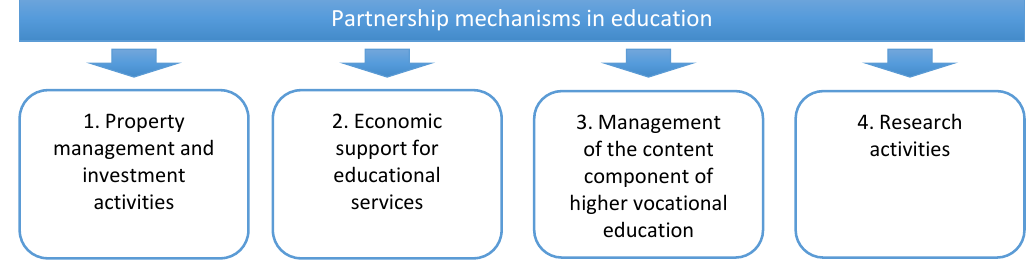
Partnership mechanisms in